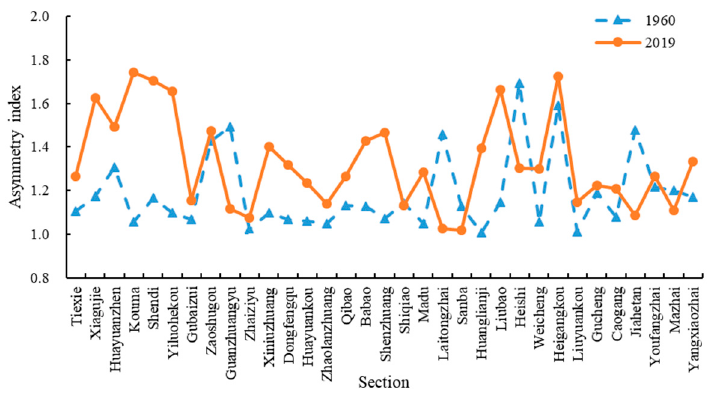
Figure 6. Asymmetry of channel cross-section in wandering section of the lower Yellow River.